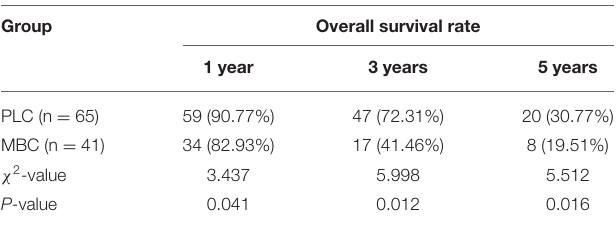
TABLE 2 | Comparison of overall survival rates between patients with PLC and MBC disease ( n , %). Group